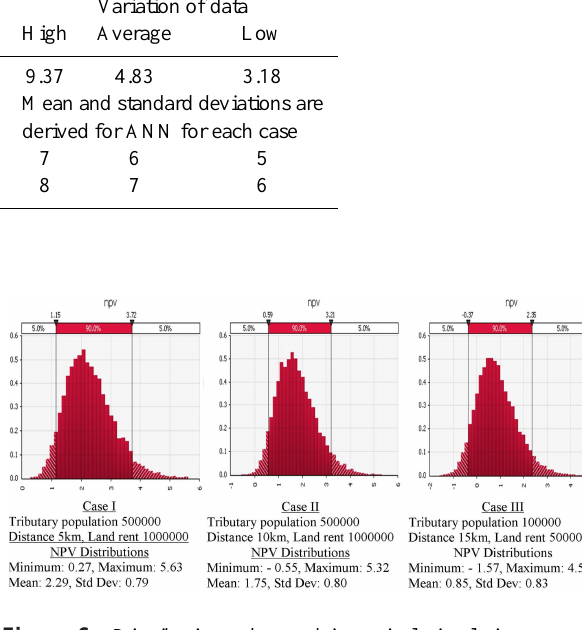
Figure 6. Distributions observed in typical simulation runs for